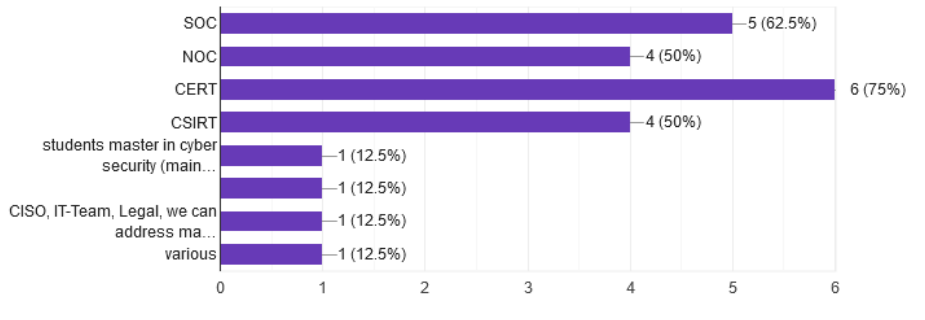
Figure 18. Roles of participants.